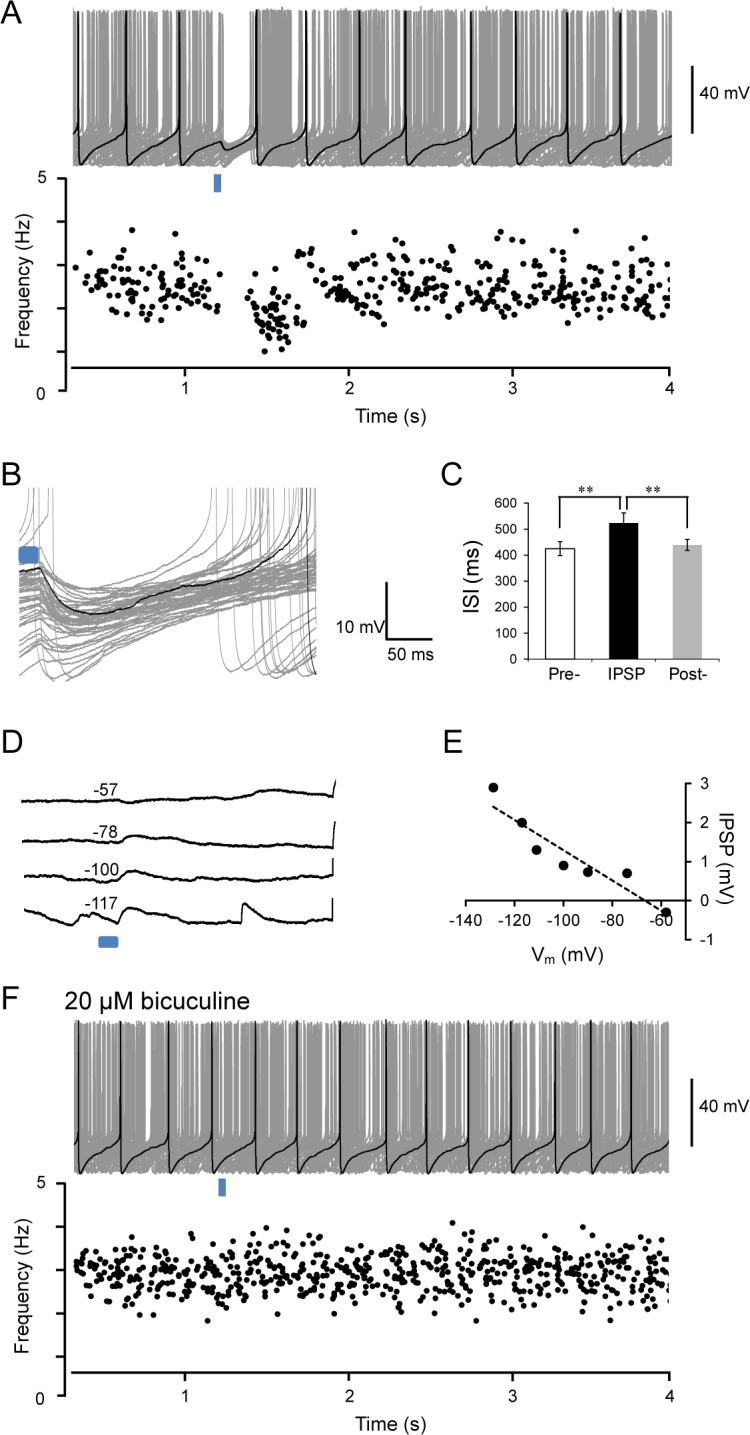
Response of LC neurons to the inhibitory postsynaptic potentials (IPSPs) that were evoked by optostimulation of these dmLC GABAergic neurons.(A) LC neuronal spontaneous firing activity was reset by light-evoked IPSP (top). The effect of light-evoked IPSPs on LC neuron firing activity was measured in instantaneous firing frequency histogram (bottom) Light pulse: 10 ms. (B) Light-evoked IPSPs are better seen at extended scale of A. (C) The effect of light-evoked IPSPs on inter-spike interval (ISI) were represented by bar graph. (D) The light-evoked IPSP is strongly influenced by membrane potential of LC neuron. (E) The equilibrium potential for IPSP close to -60 mV. (F) A GABAA receptor antagonist, 20 μM bicuculline completely abolished light-evoked IPSPs of LC neuron. Data are presented as means ± SE (n = 15 cells, three animals).